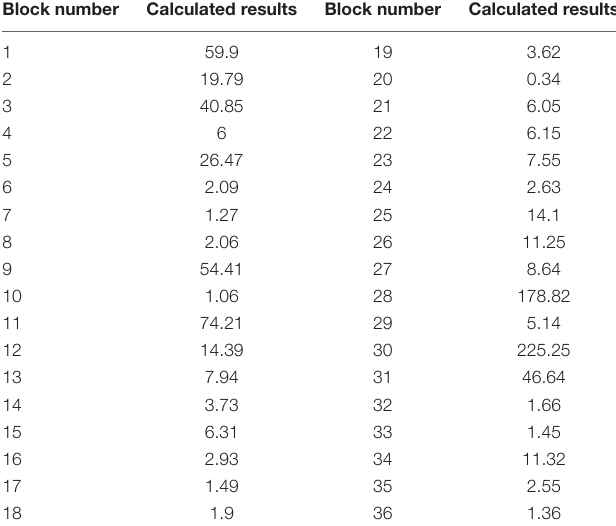
TABLE 5 | Comprehensive calculation results of mangrove ecosystem service functions.